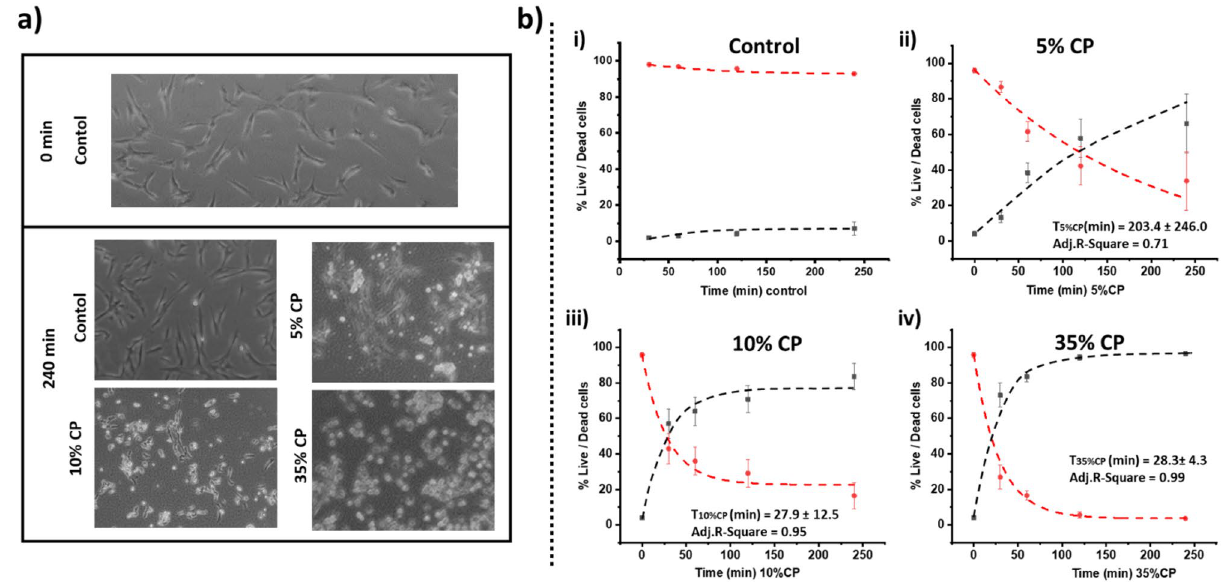
Figure 4. Impact of CP on human dental pulp stem cells (HDPSCs) viability. ( a ) Microscopic imaging showing the change in cell shape and morphology in the treatment groups compared to control. ( b ) Fitted plots showing the percentage of live/dead cells over time for the control group (no CP exposure) (i) and the three treatment groups (ii-iv) with exponential decay over the population of live cells (in red) and dead cells (in black).